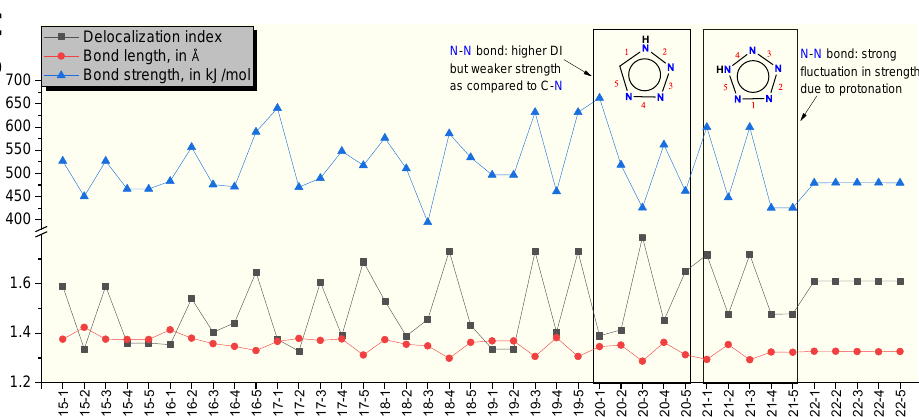
Figure 3. (A) Average delocalization index (DI) of the bonds in the ring for the 21 cyclic compounds. (B) DI, length, and strength for individual bonds in the rings of the six-membered compounds and (C) five-membered compounds. X-Y in x -axis denotes bond Y of compound X; the Y bond indices for each compound are illustrated in Table 1.